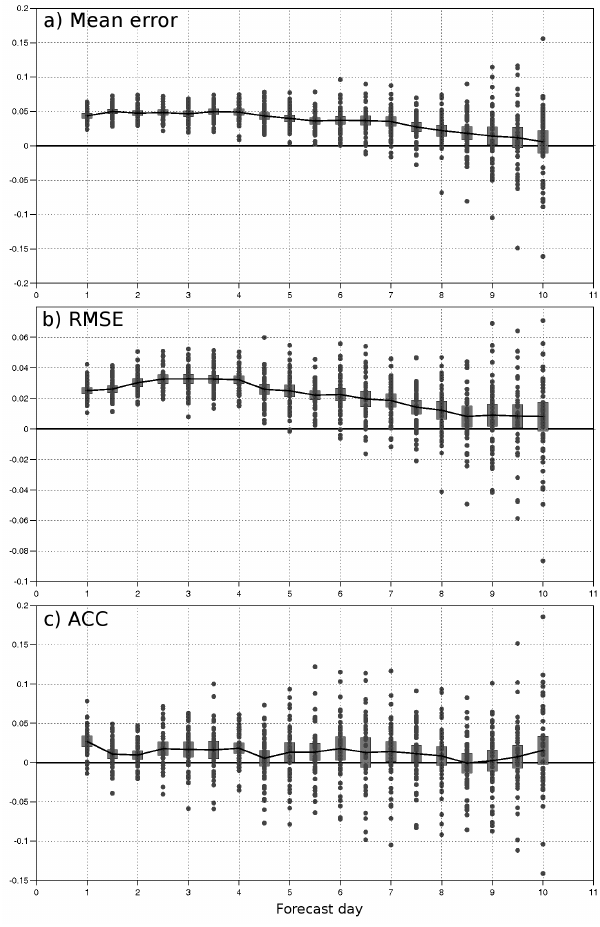
Fig. 3. Forecast skill score differences between the default model and the optimized model for the 500hPa geopotential height in the tropics (20 ◦ S to 20 ◦ N). Notation: positive difference implies that the optimized model is more accurate. (a) Mean error, (b) RMSE, (c) ACC. Included are 45 forecast cases between 12 May and 8 Au- gust 2012 for individual score difference (dots), its mean (contin- uous line) and the 95% confidence interval of the mean (vertical